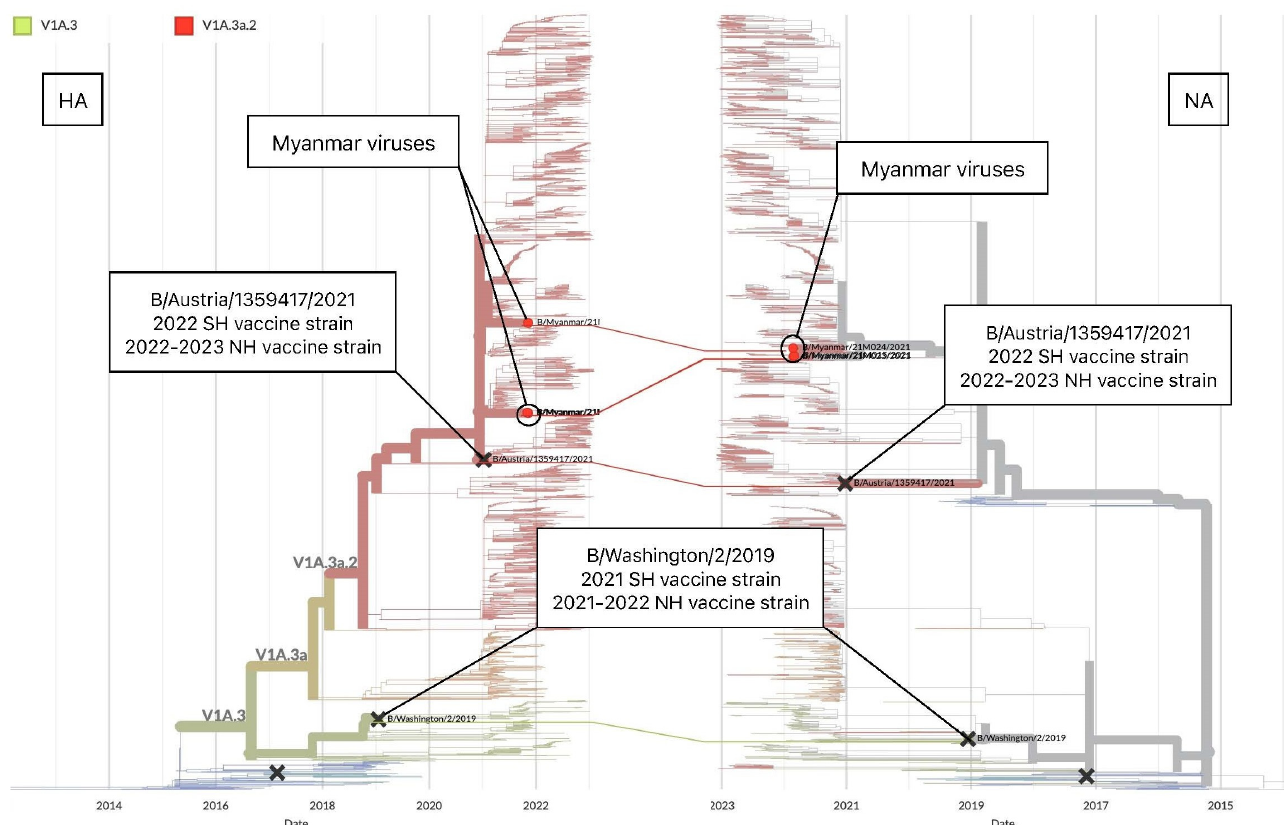
Figure 5. Tanglegram of the HA and NA segments of B/Victoria viruses collected in November 2021 in Myanmar with a time scale of 2 years displayed by Nextstrain (accessed on 17 February 2023) [28]. Comparative topology of the HA and NA segments of the B/Victoria viruses collected in 2021 in Myanmar during this study and vaccine strains of the 2021 and 2022 seasons.